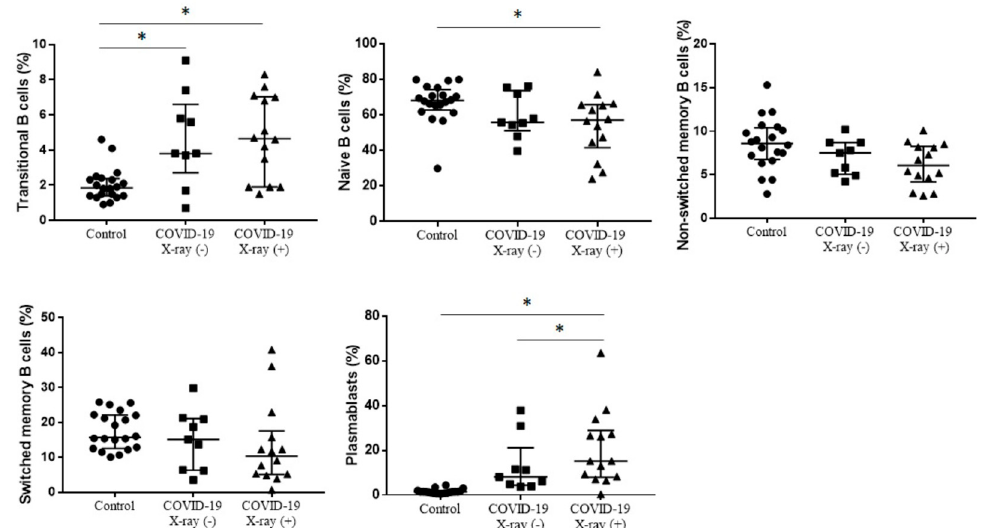
Figure 3. The differences in the median proportion of B lymphocytes maturation subsets: Transitional B cells, naïve B cells, non-switched memory B cells, class switched memory B cells and plasmablasts between healthy patients (Control), patients with COVID-19 without interstitial lesions on chest X-ray (COVID-19 X-ray ( − )) and with interstitial lesions on chest X-ray (COVID-19 X-ray (+)). Graphs show the median values and quartile Q1—Q3 (* p < 0.05). Table 3. Differences in the proportion of B and T lymphocytes maturation between healthy patients ( A ), patients with COVID-19 without interstitial lesions on chest X-ray (( B ): COVID-19 X-ray ( − )) and patients with COVID-19 with interstitial lesions on chest X-ray (( C ): COVID-19 X-ray (+)). Data expressed as median (Q1–Q3).